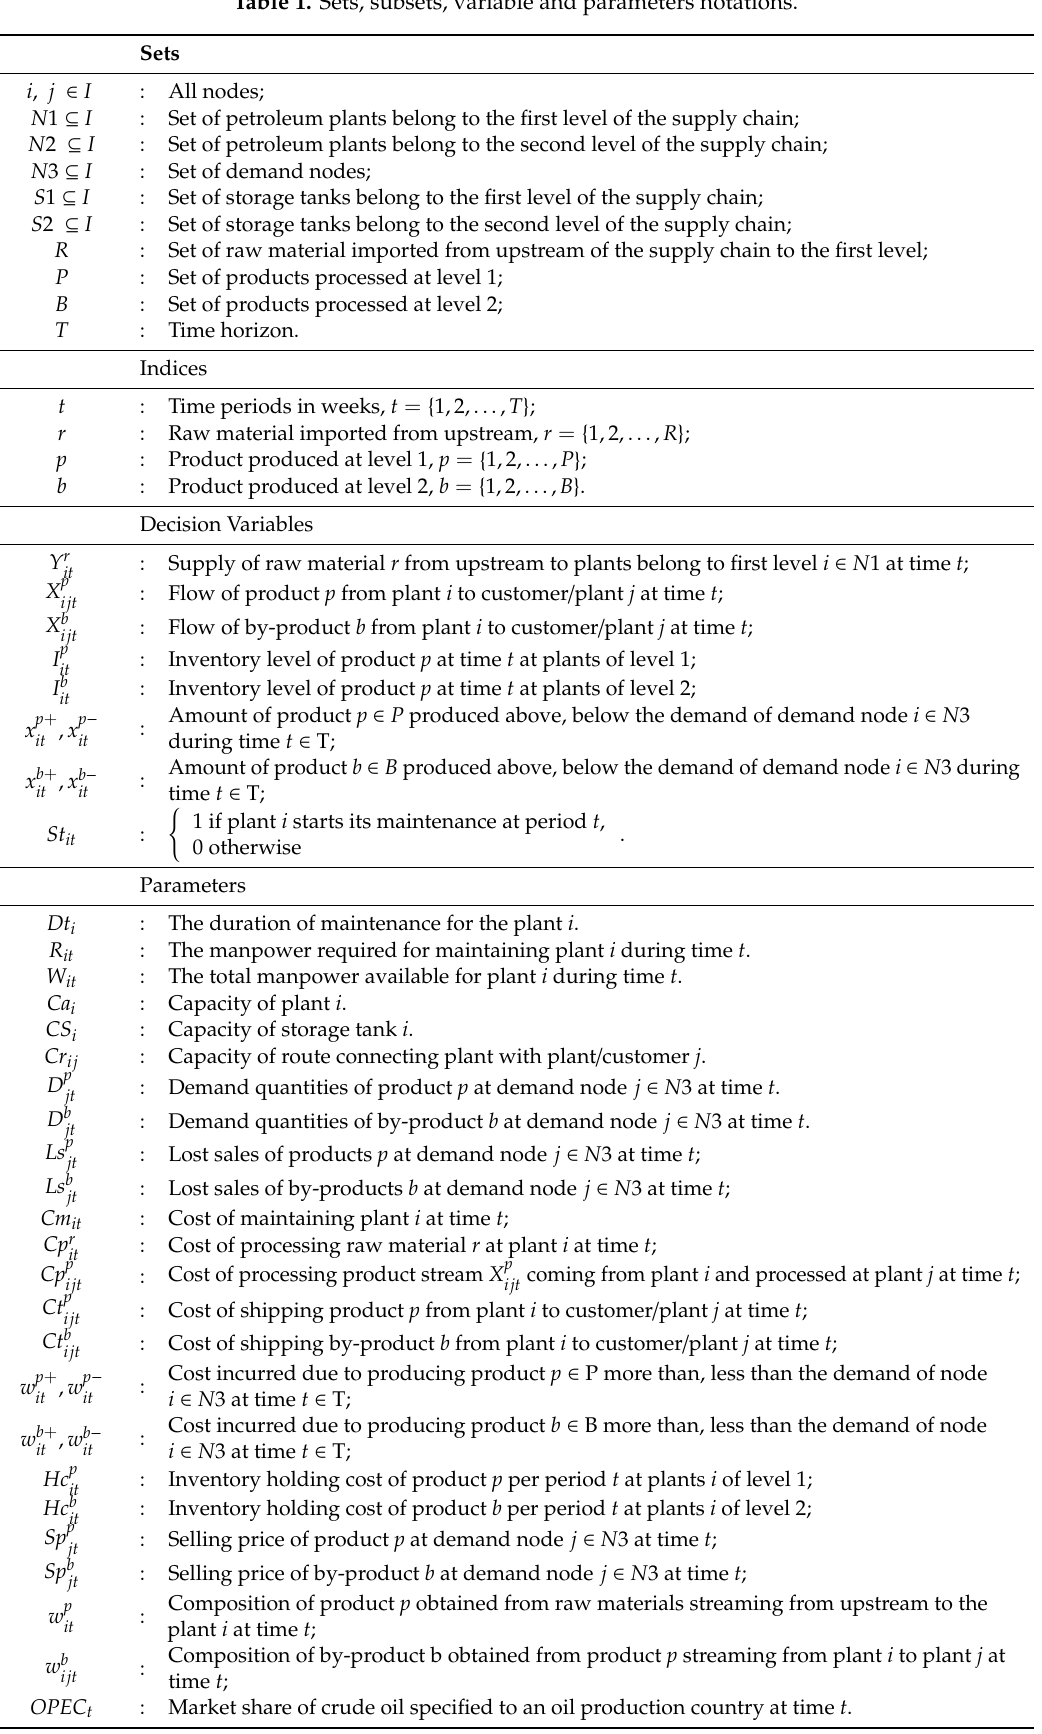
Table 1. Sets, subsets, variable and parameters